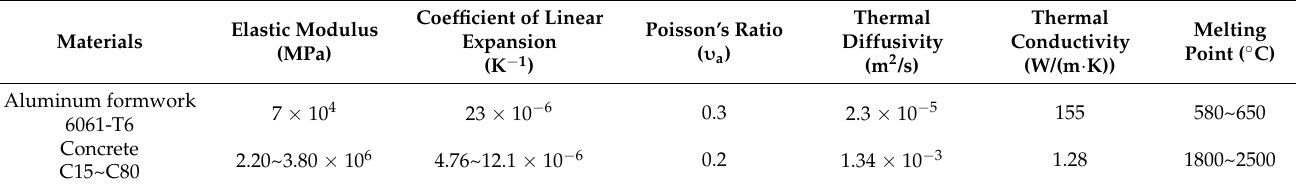
Table 1. Physical performance parameters of architectural aluminum formwork and its attached